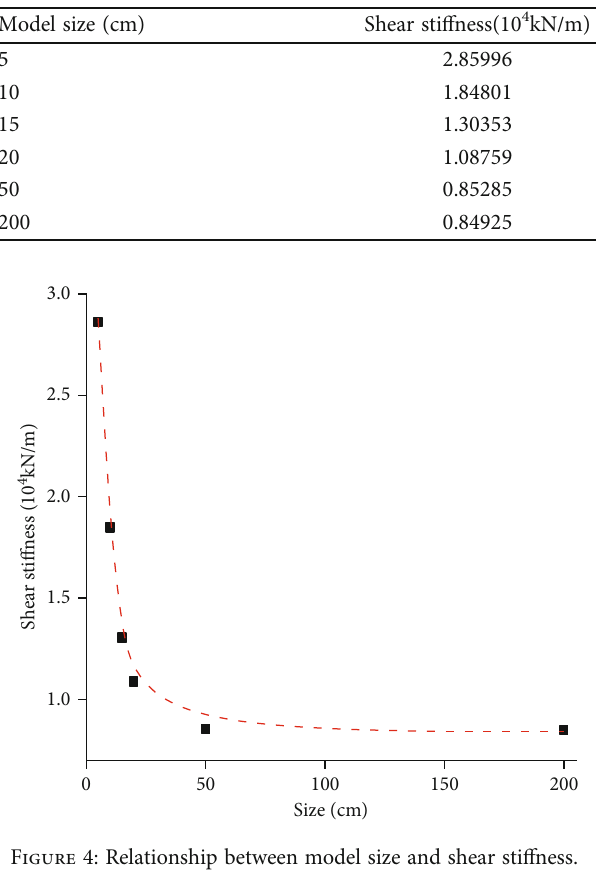
Table 4: Relationship between model size and shear sti ff ness of through-type joint.